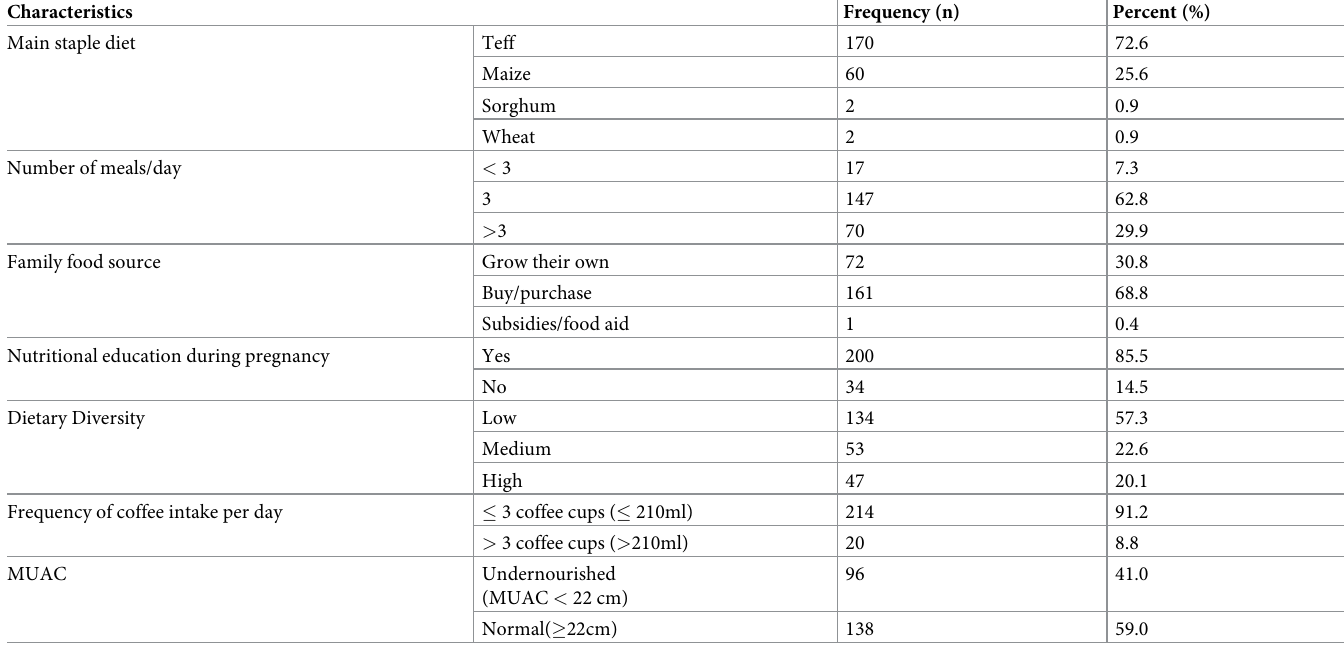
Table 4. Nutrition related Characteristics of pregnant women attending antenatal care at Debre Markos Referral Hospital, Northwest Ethiopia, 2016. Characteristics